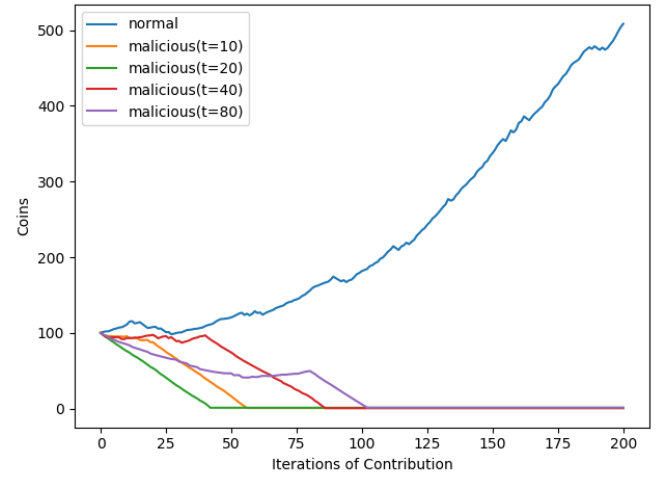
Figure 9. Changes of cryptocurrencies held by each contributor and attacker ( p =